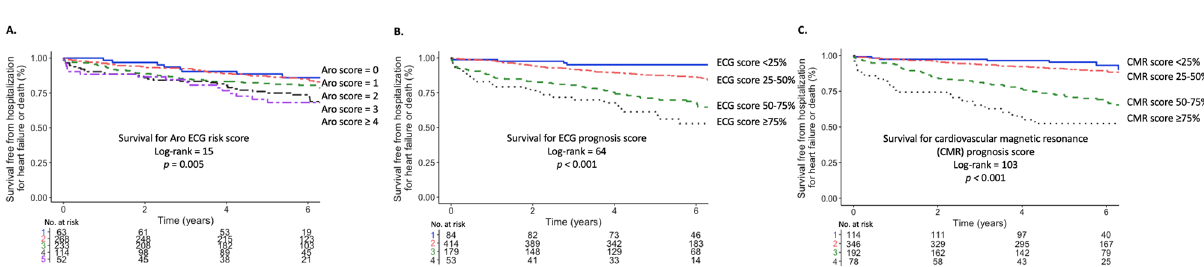
Figure 2. Kaplan Meier curves showing survival for ( A ) the ECG prognosis score, ( B ) cardiovascular magnetic resonance (CMR) prognosis score, and ( C ) patients with normal ECG and CMR scores, patients with either an increased ECG or an increased CMR score, and patients with both an increased ECG and CMR score.